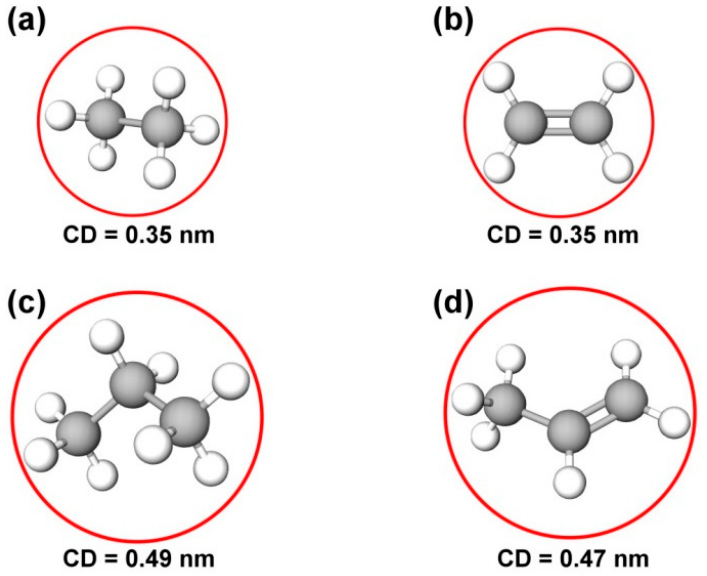
Figure 8. Critical dimensions (CD) of the main reagent and product molecules used for the modelling: ( a ) ethane; ( b ) ethylene; ( c ) propane; ( d ) propylene. The diffusion of hydrocarbons through the porous membrane worsens the overall process efficiency. As shown in Figure 9a,b, at a pore diameter of 0.5 nm and above, the alkene concentration profiles go through the maximum and exhibit a declining tendency at the reactor outlet. Figure 9c,d demonstrates the cumulative amount of hydrocarbons that appeared in the shell side. In both cases, this amount increases with the pore